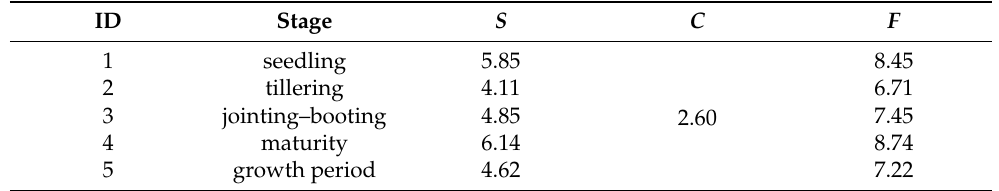
Table 3. Average infiltration, percolation and seepage (mm · d − 1 ) of the paddy field. ( S is the seepage, C is the percolation and F is the